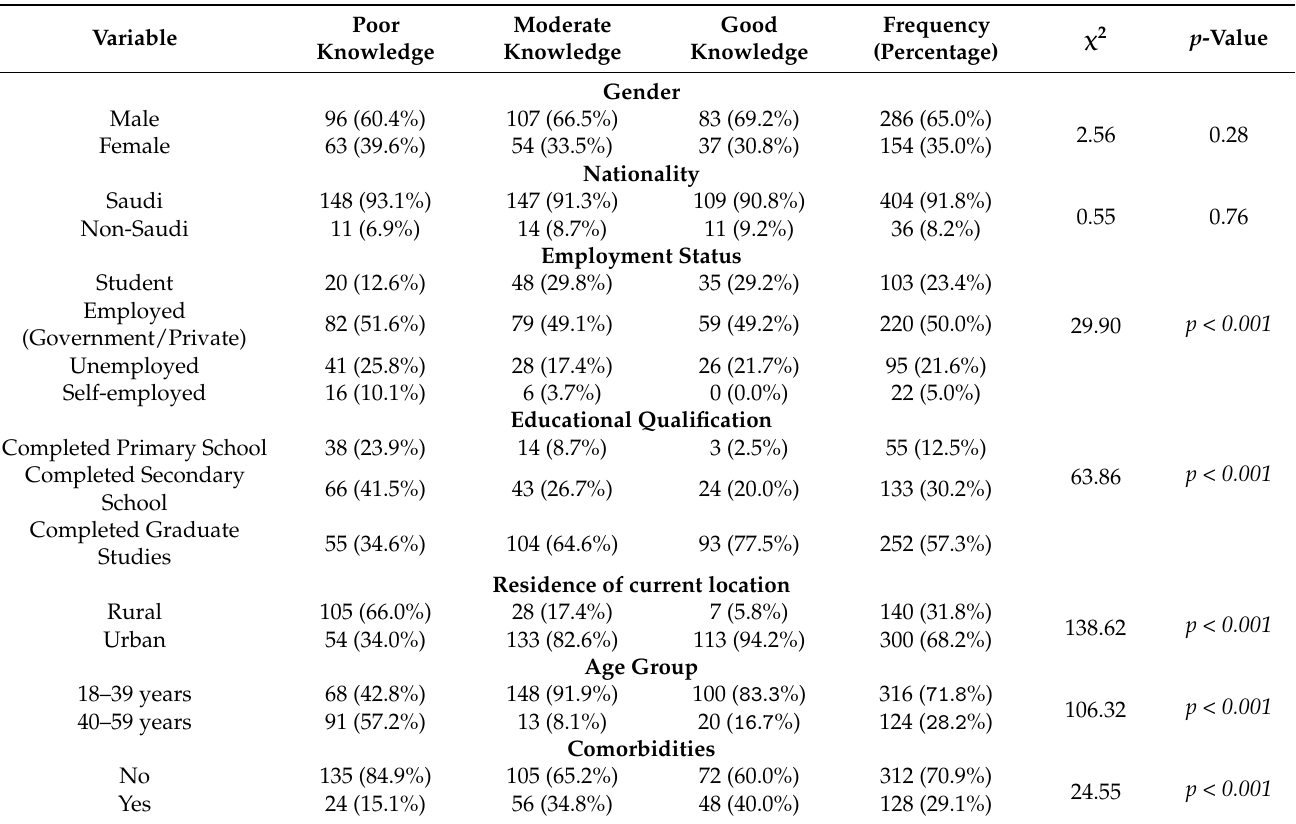
Table 2. Cross-tabulations—Participants’ socio-demographics and knowledge